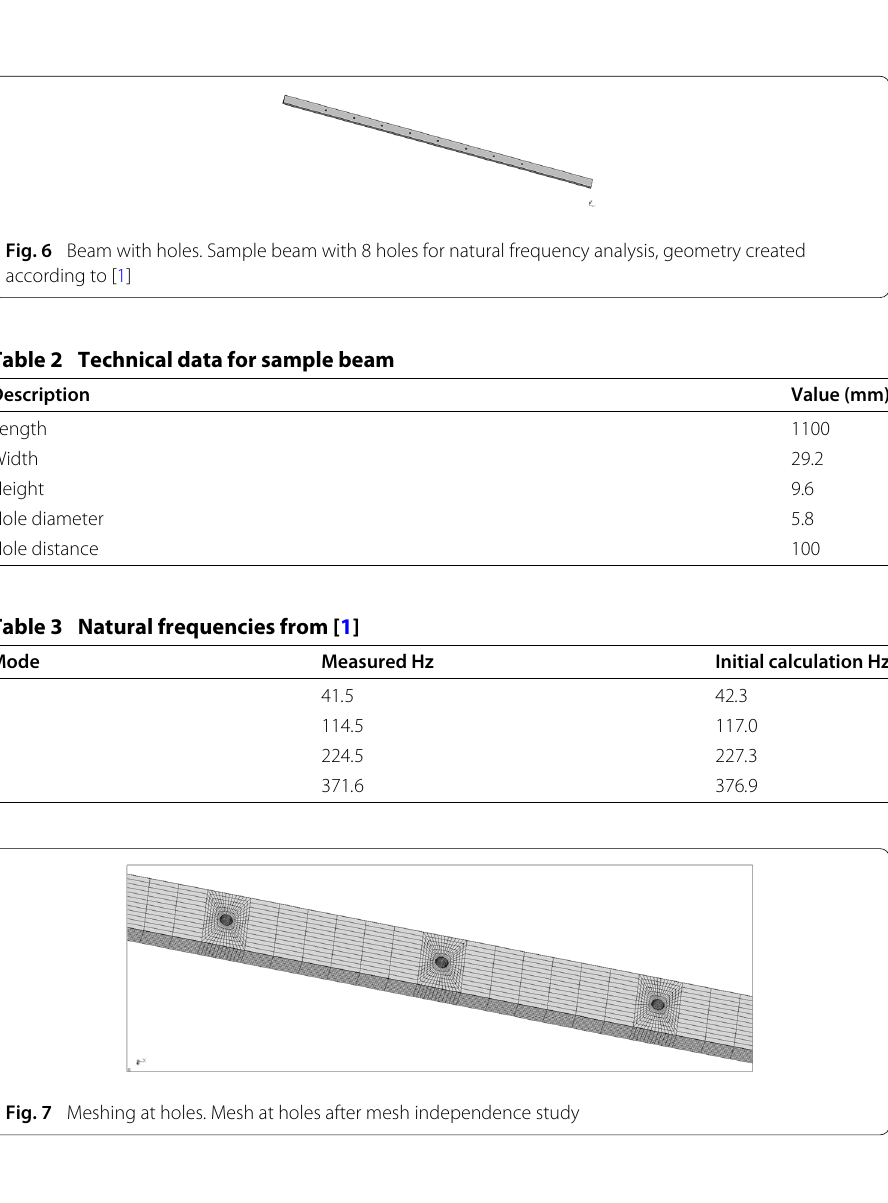
Natural frequencies of a beam with